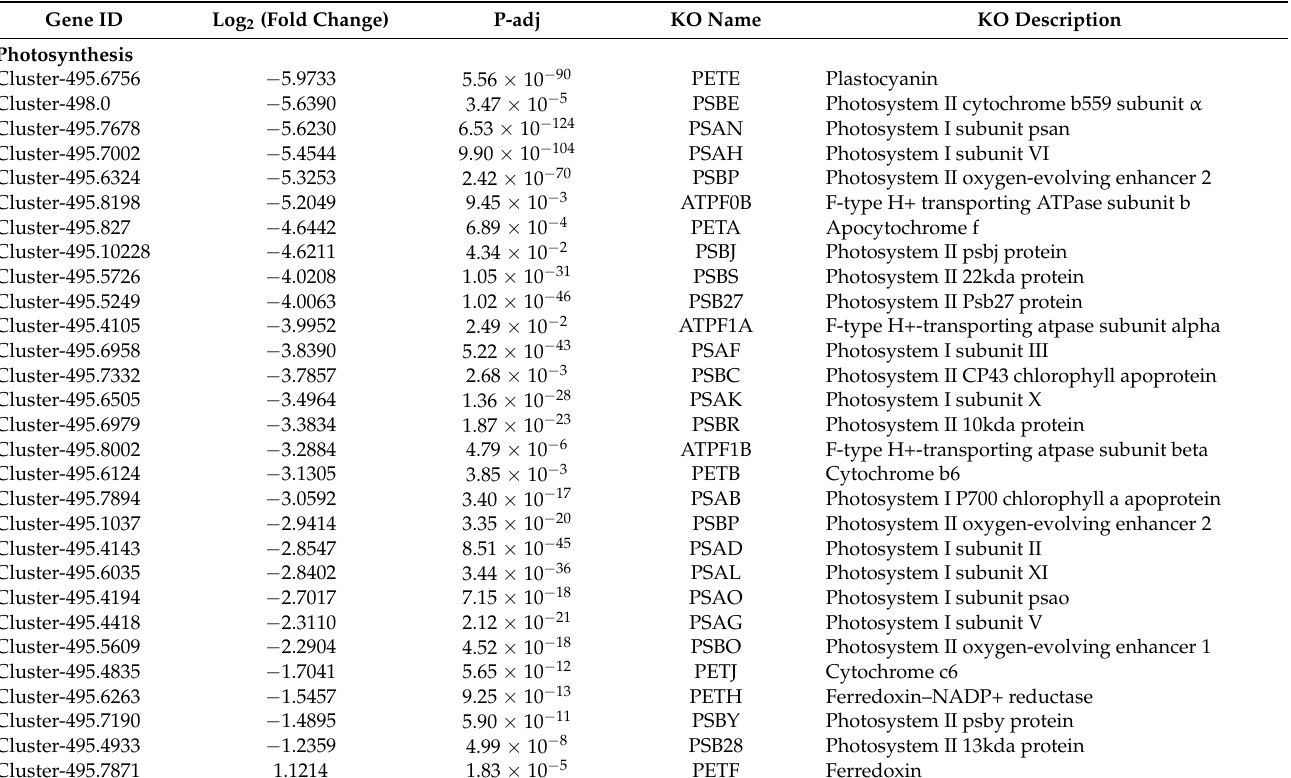
Table 2. Differentially expressed genes in the photosynthetic